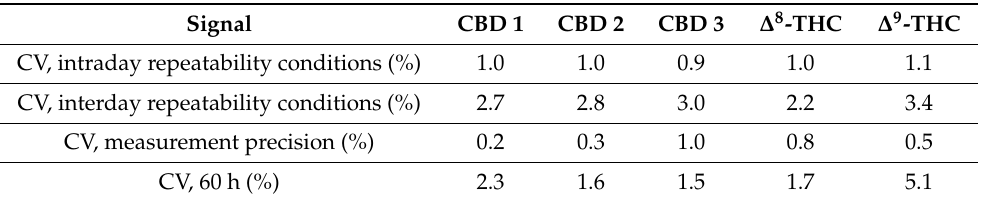
Table 4. Coefficient of variation (CV) and measurement precision (N = 5 measurements) of different cannabinoid signals.